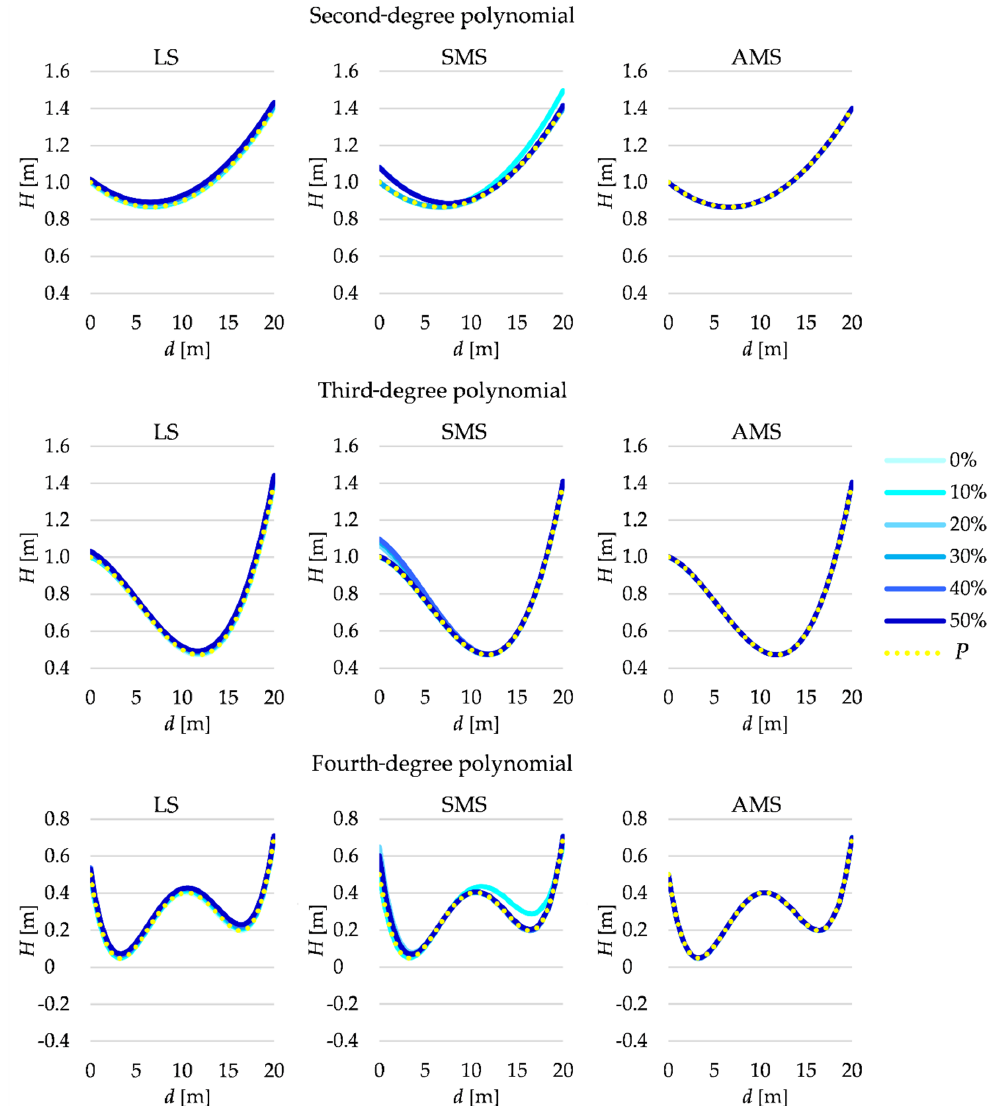
Figure 4. Estimated terrain profiles for LS, SMS and AMS estimates for different percentages of outliers.